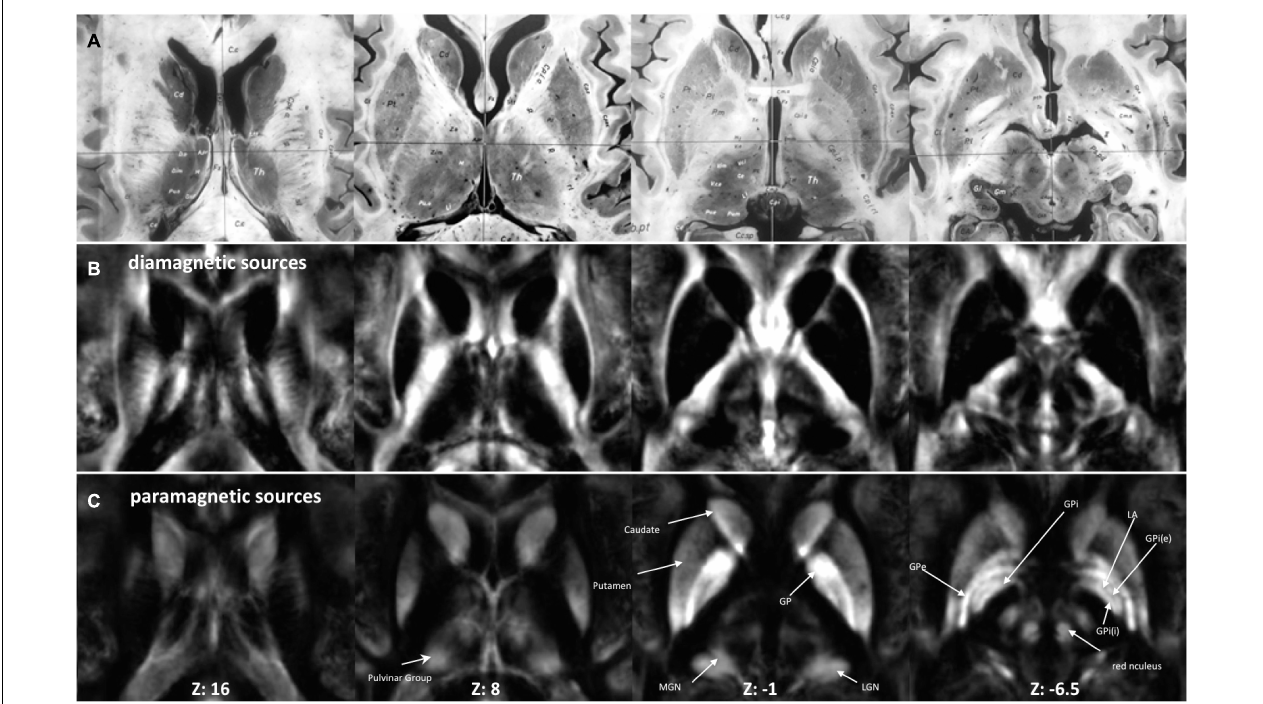
FIGURE 2 | Anatomy and MRI of thalamus (Th) and basal ganglia (BG): (A) four selected slices were adapted (Schaltenbrand and Bailey, 1959) (B,C) Corresponding QSM images of diamagnetic and paramagnetic sources. GPe, external segments of the globus pallidus; GPi, internal segments of the globus pallidus; GPi (e), subsegment of internal segments of the globus pallidus; GPi (i), subsegment of internal segments of the globus pallidus; LGN, lateral geniculate nucleus; MGN, medial geniculate nucleus; LA, lamina accessoria.